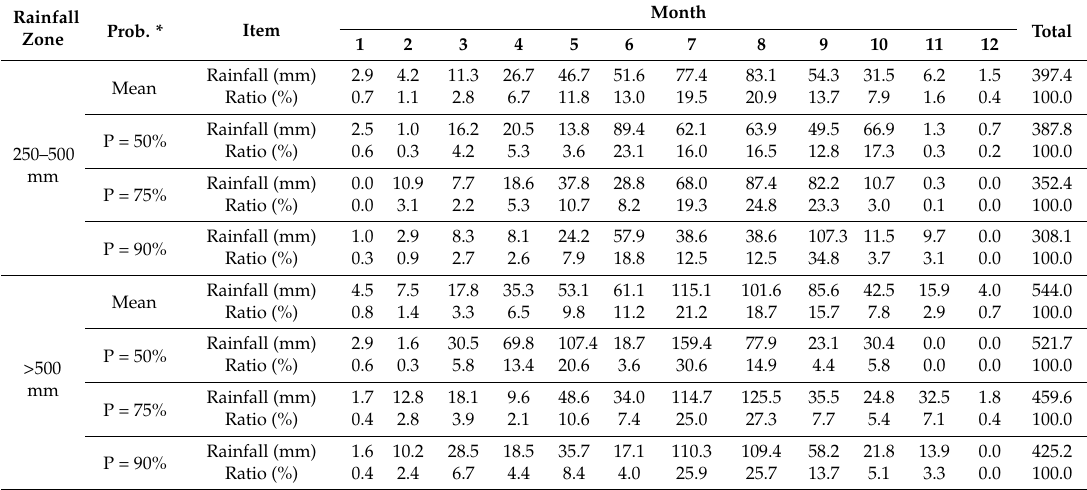
Figure 1. Location map of Gansu Province and the weather stations at Anding and Sifang. The results indicate that for the two rainfall stations at Anding and Sifang, the mean annual rainfall is about 397.4 mm and 544.0 mm, respectively. The 50% rainfall probabilities for these two stations are 387.8 mm and 521.7 mm, respectively; the 75% rainfall probabilities are about 352.4 mm and 459.6 mm, respectively; and the 90% rainfall probabilities are about 308.1 mm and 425.2 mm, respectively. The long-term monthly rainfall distributions for both stations are listed in Table 5. According to the long-term monthly rainfall distribution (Table 5), the wet season (June to September) comprises 67% and 66.8% of the total annual rainfall at Anding and Sifang, respectively, and the other months (October to May the following year) comprise only about 33% and 33.2% of the total annual rainfall, respectively. Table 5. Monthly distributions and return probabilities of rainfall at both stations.